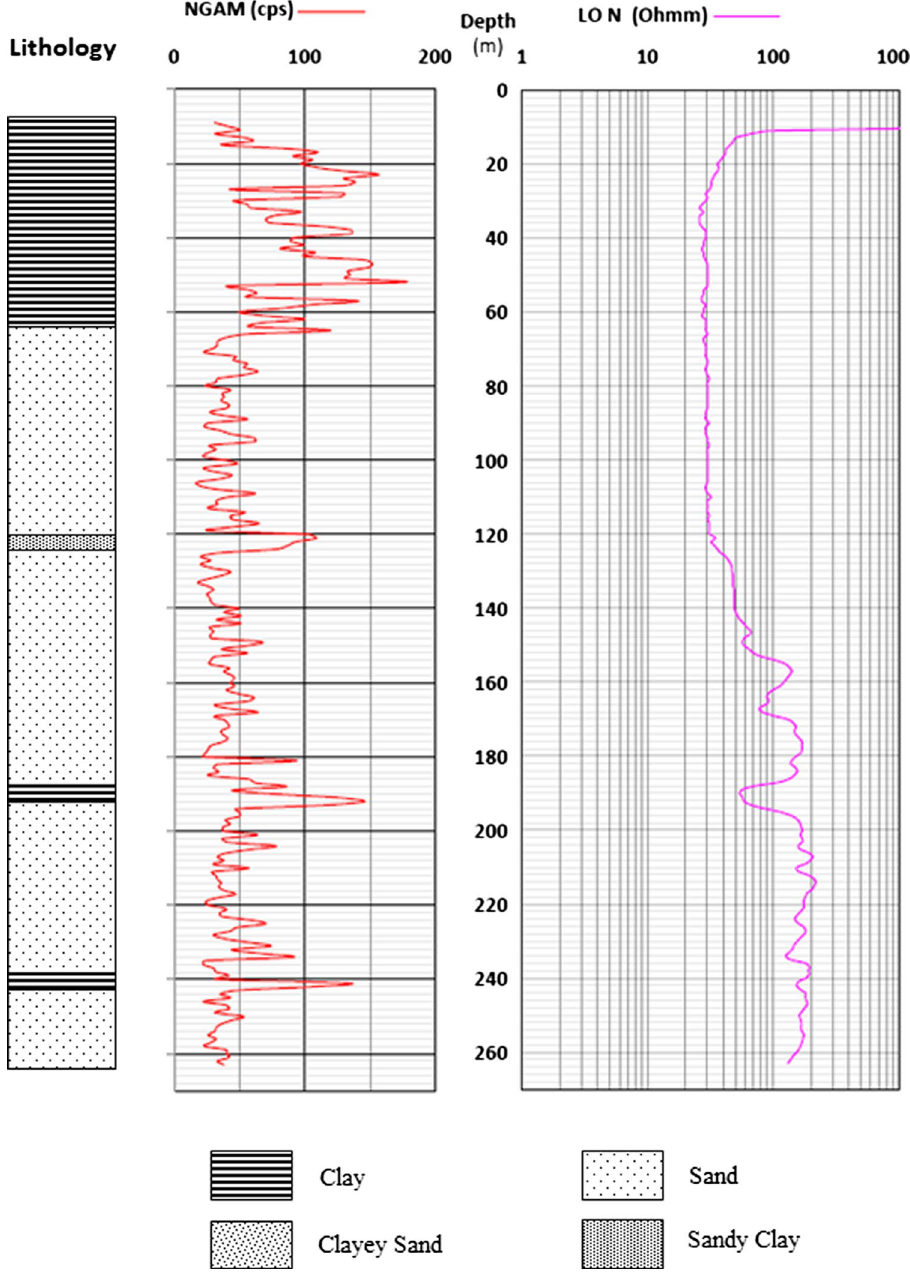
Fig. 4 Digitized lithologic and geophysical borehole logs of BH